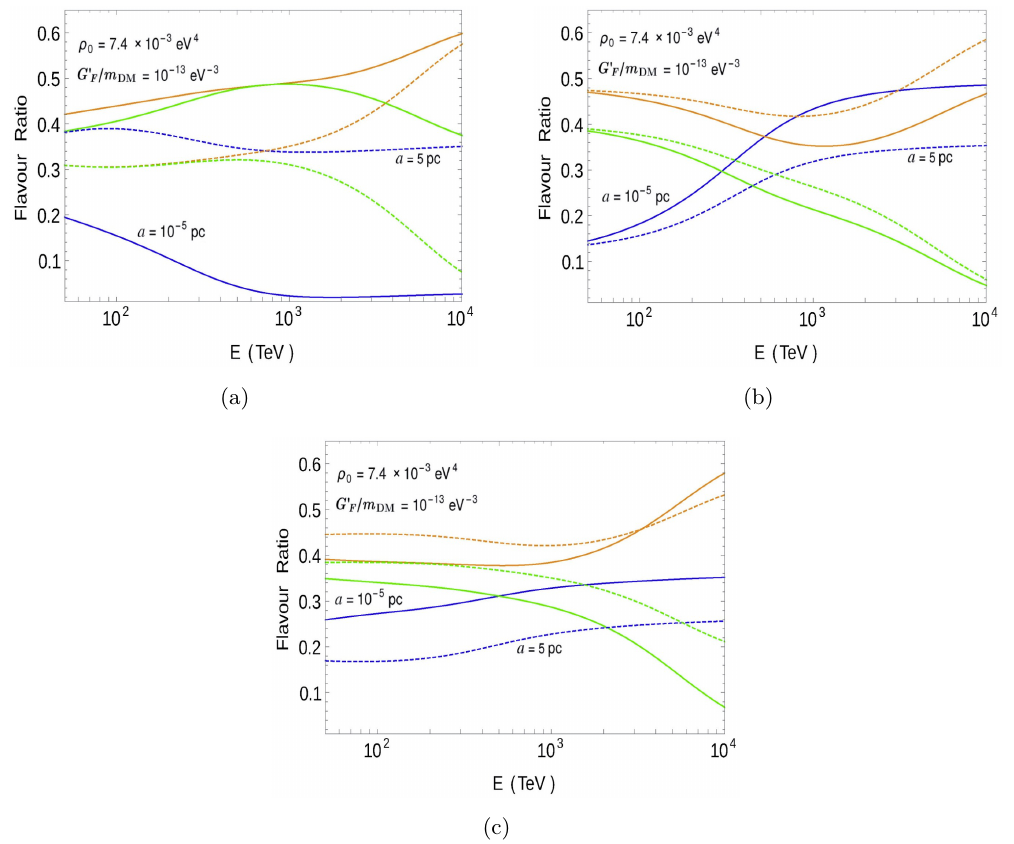
) and (b) antineutrinos α ). The blue, orange and green lines α